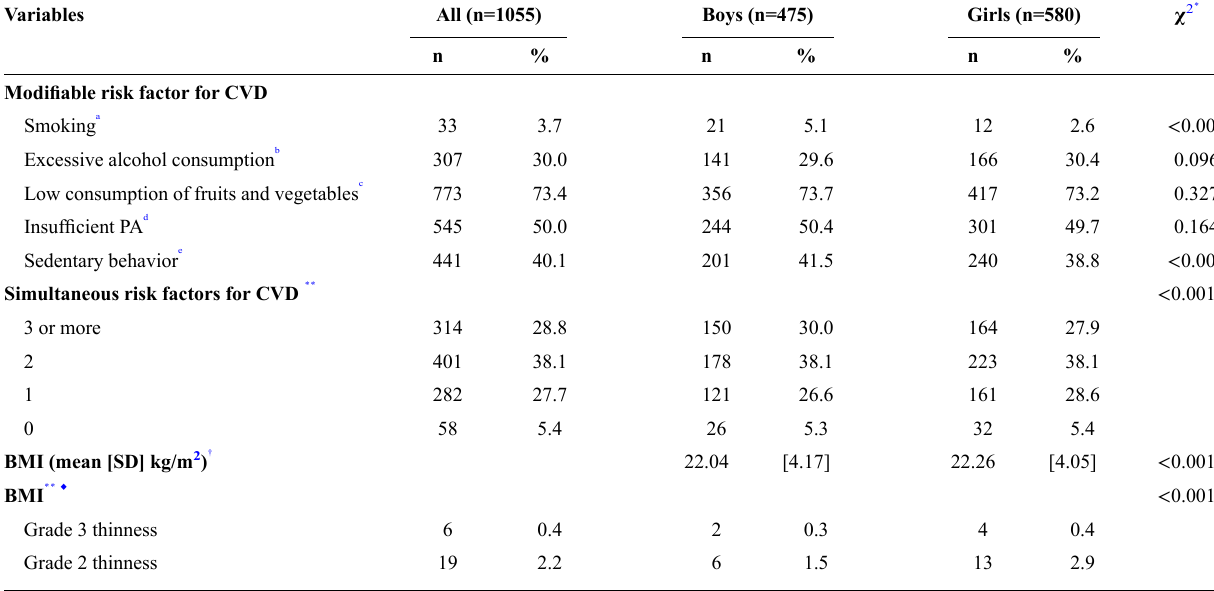
Table 1 - Sample characteristics. ACtVU Study. Uberaba, Brazil (2015).